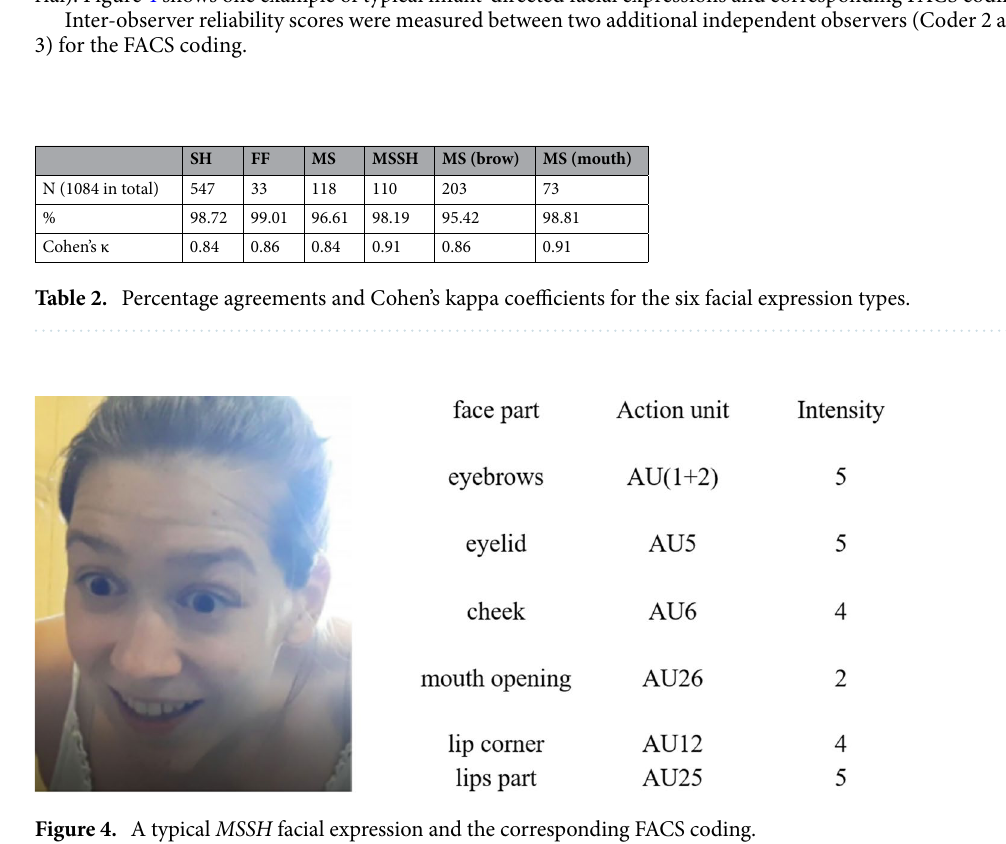
Figure 4. A typical MSSH facial expression and the corresponding FACS